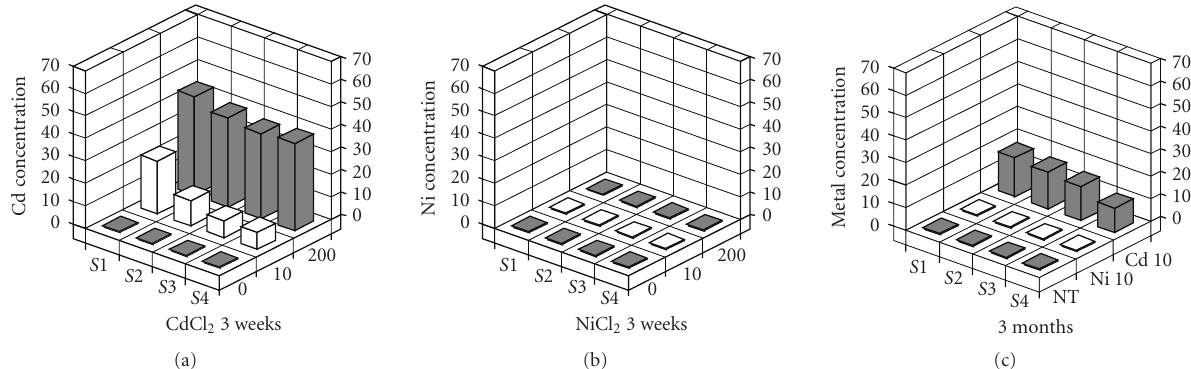
Figure 3: Heavy metal accumulation in E. fetida . Each data point represents the mean of three individuals. Heavy metal concentrations were measured by atomic absorption spectrometry, and are expressed as μ g per body weight. (Data are modified by Nakashima et al. [18]).